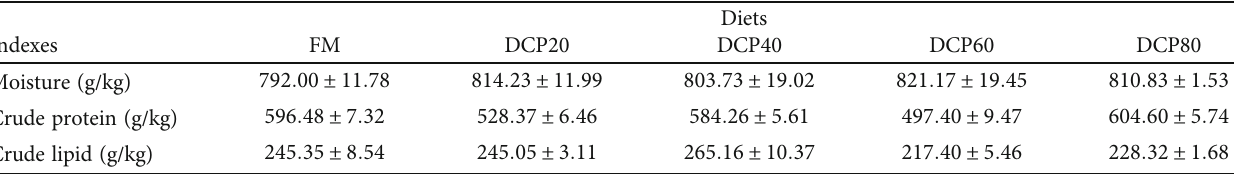
Figure 3: The broken line model for the relationship between SGR and dietary DCP replacement levels of juvenile large yellow croaker fed the trial diets. Table 3: E ff ect of degossypolized cottonseed protein on body composition of whole body in juvenile fed the trial diets (g/kg dry matter, means ± SEM, n = 3 ) 1